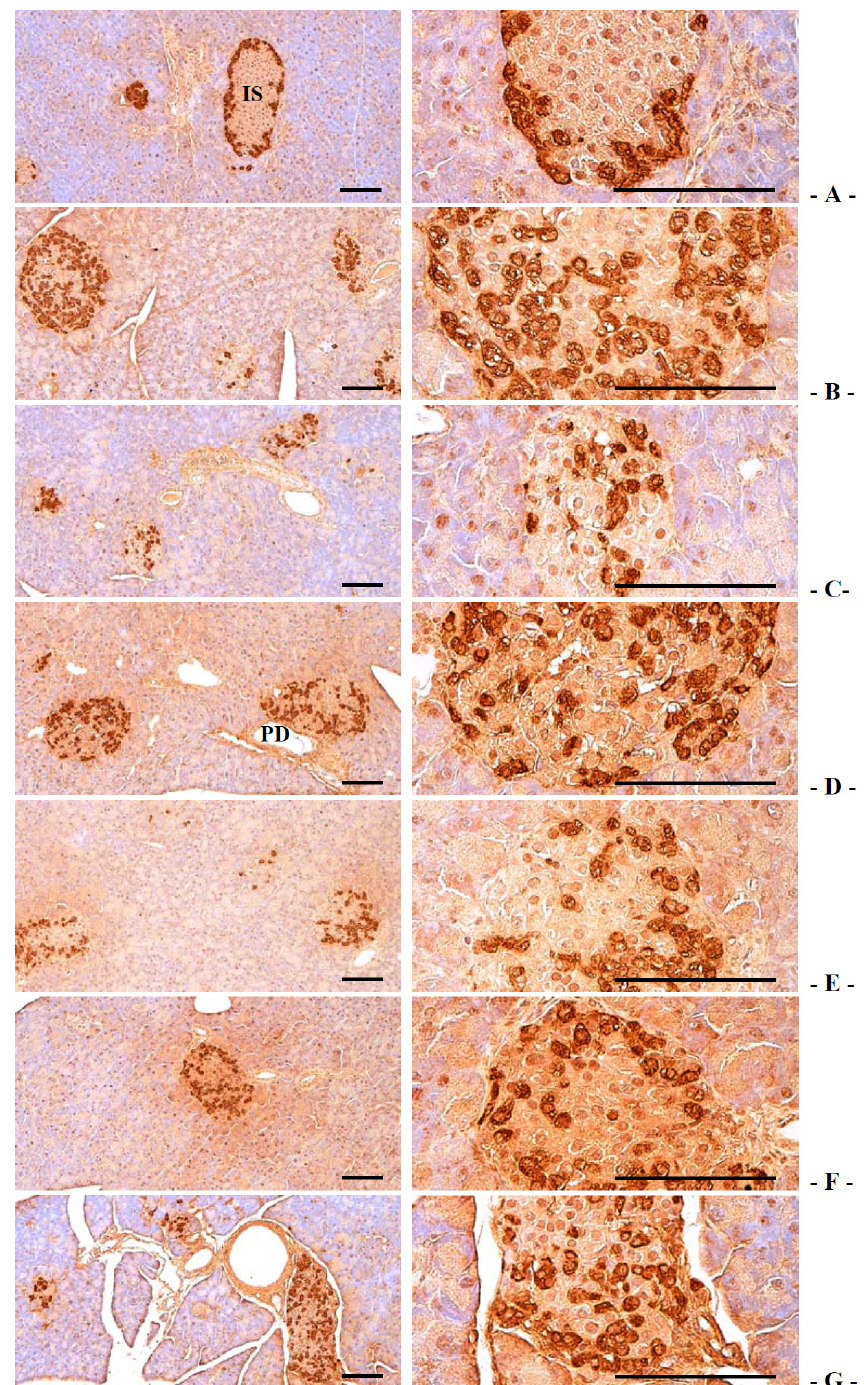
Figure 6. Representative histological images of the glucagon-immunoreactive cells in the pancreas, taken from intact normoglycemic or db/db mice. ( A ) Intact control mouse; ( B ) db control mouse; ( C ) metformin 250 mg/kg treated db mouse; ( D ) GT 400 mg/kg treated db mouse; ( E ) fGT 400 mg/kg treated db mouse; ( F ) fGT 200 mg/kg treated db mouse; ( G ) fGT 100 mg/kg treated db mouse. GT, Green tea aqueous lyophilized extracts; fGT, Aquilariae Lignum-fermented green tea aqueous lyophilized extracts; IS, pancreatic islet; PD, pancreatic secretory duct. All immunostained by avidin-biotin-peroxidase complex. Scale bars = 80